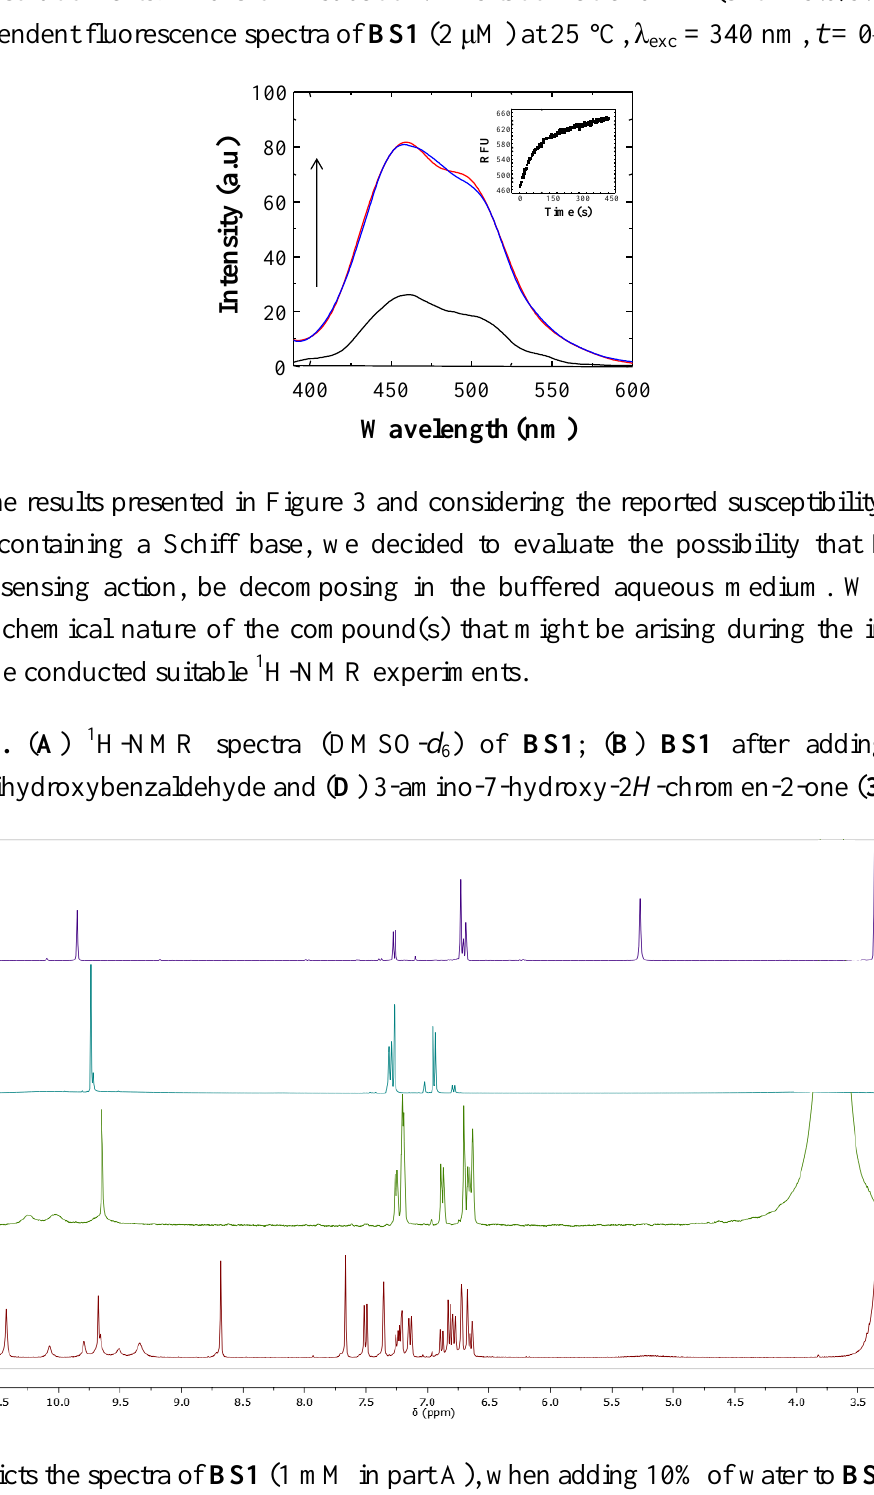
Figure 3. Fluorescence spectra of BS1 recorded at different times. The black line represents the fluorescence intensity of a freshly prepared solution of BS1 (2 µM) in 30 mM HEPES buffer, pH 7.4, 1% DMSO; the blue line represents the fluorescence intensity of the same solution after 360 s of incubation; and the red line represents the fluorescence intensity of the same solution after 720 s of incubation. Excitation at 340 nm (slit = 5.0/5.0).